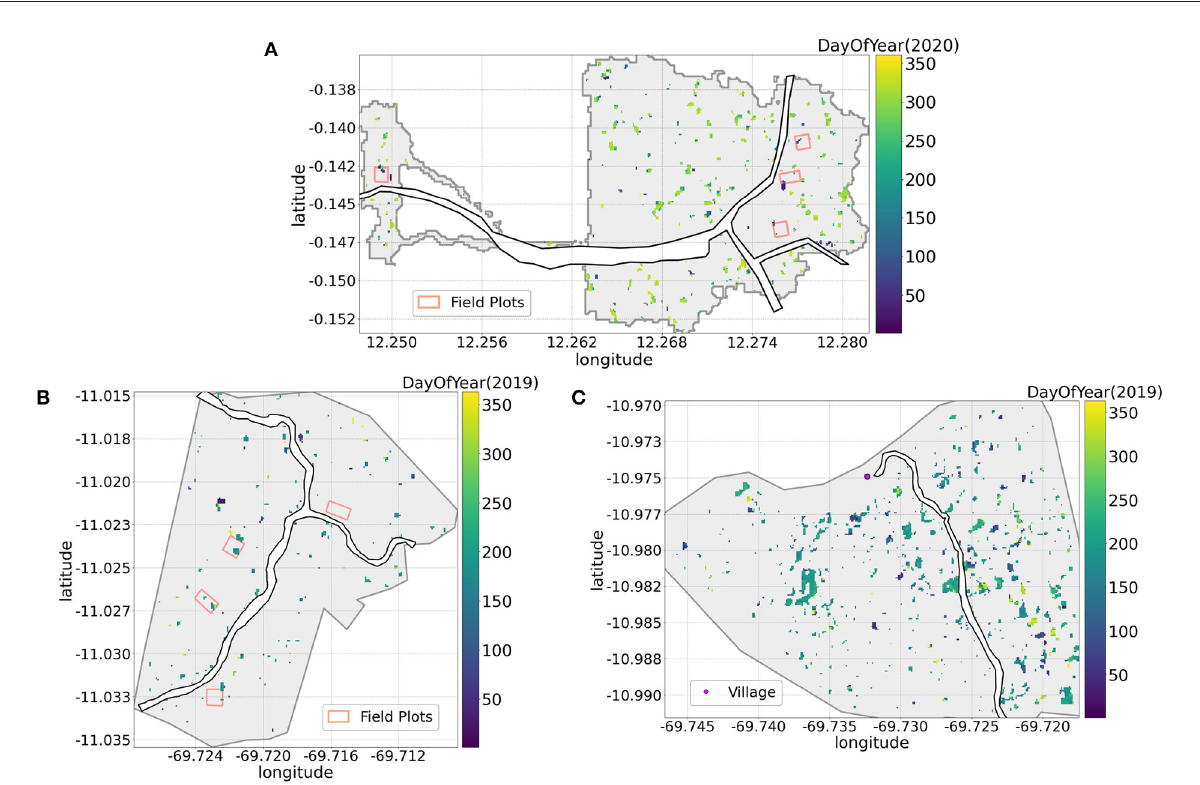
FIGURE7 Dates of forest disturbance during the period of interest, determined as the year when the field sites were selectively logged. Dates are reported in Day of Year units (1–366); (A) Dates of forest disturbance in Gabon, for changes during the year 2020; (B) Dates of forest disturbance in Peru, showing changes occurred during the year 2019 in our study areas in proximity of the field sites and (C) near the